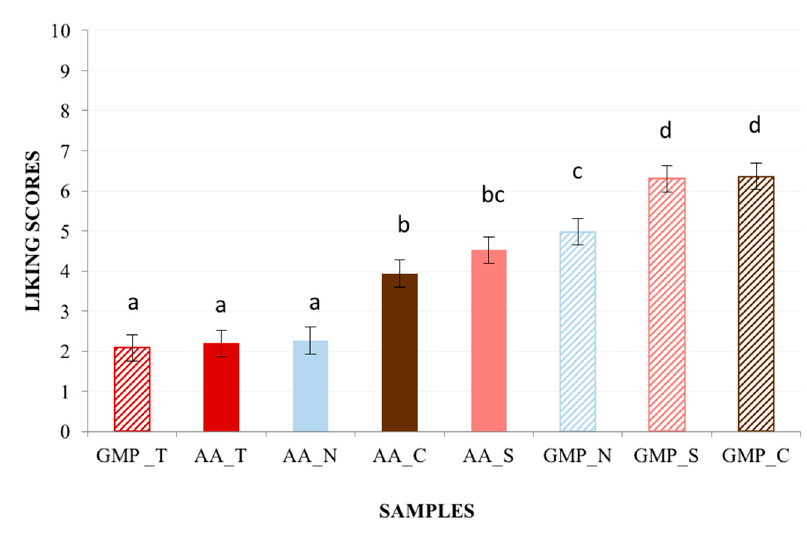
Figure 1. Liking score ± standard error mean (SEM) by samples. Different letters indicate significant differences according to post hoc test (Patients n = 86).